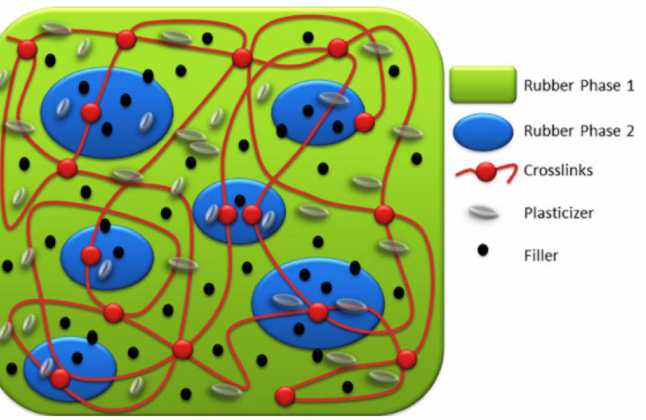
Figure 5. Pictorial representation of a cross-linked typical rubber blend with additives [33].